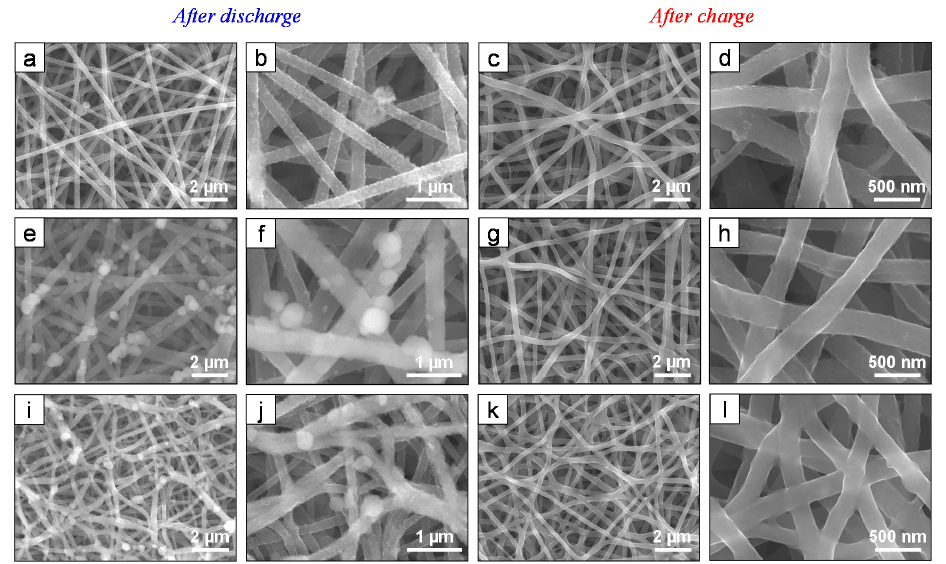
Figure 4. Electron microscope images of ( a – d ) CNF 1000, ( e – h ) CNF 1200 and ( i – l ) CNF 1400 after the discharging and charging.